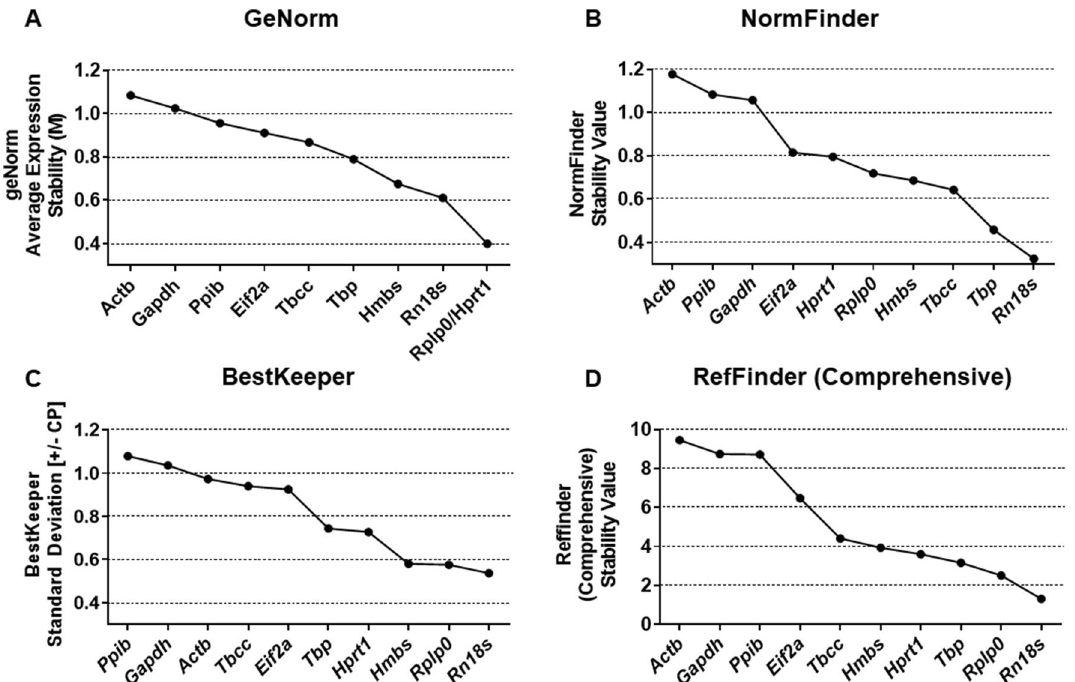
Figure 3. Determination of the most stable reference gene by geNorm (RefFinder), NormFinder, BestKeeper, and RefFinder (Comprehensive). The lower the stability value, the more stable the reference gene according to ( A ) GeNorm and ( B ) NormFinder. RefFinder’s GeNorm algorithm also gives us the best combination of genes that can be used for accurate normalization. ( C ) Reference genes with high standard deviation (SD) and Coefficient of Variation (CV) is considered unstable for normalization according to BestKeeper. Lower the SD value, greater the stability. ( D ) RefFinder provides a final comprehensive ranking by combining the results obtained from GeNorm, NormFinder, BestKeeper and also Delta-Ct (not